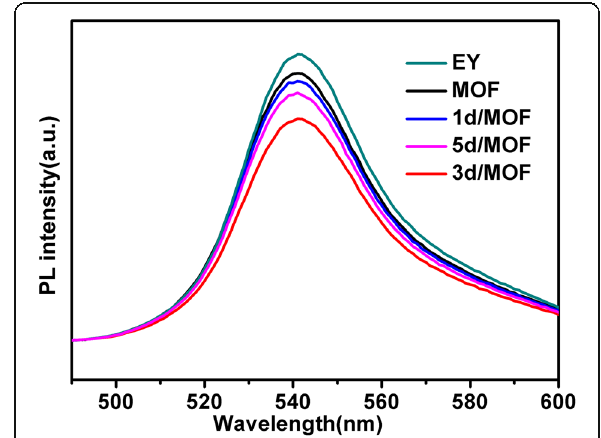
Fig. 11 Fluorescence spectra of the EY-sensitized MOF, Pd/MOF 1%, Pd/MOF 3%, and Pd/MOF 5% samples in 15% ( v / v ) TEOA aqueous solution at pH 10